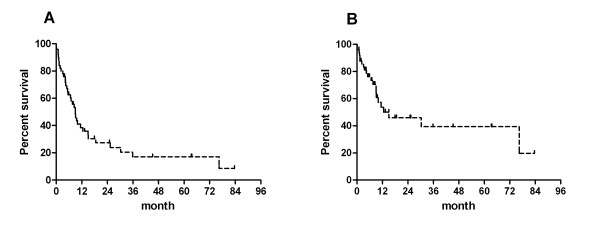
Kaplan-Meier curves showing the observed LuTx-free (A) and observed overall (B) survival from initiation of continuous intravenous iloprost. Patients at risk n = 50, n = 16, n = 10, n = 6, n = 5, n = 5, n = 3 at BL-ilo, 12, 24, 36, 48, 60 and 72 months after initiation of iloprost therapy (observed survival). |: censored patients.